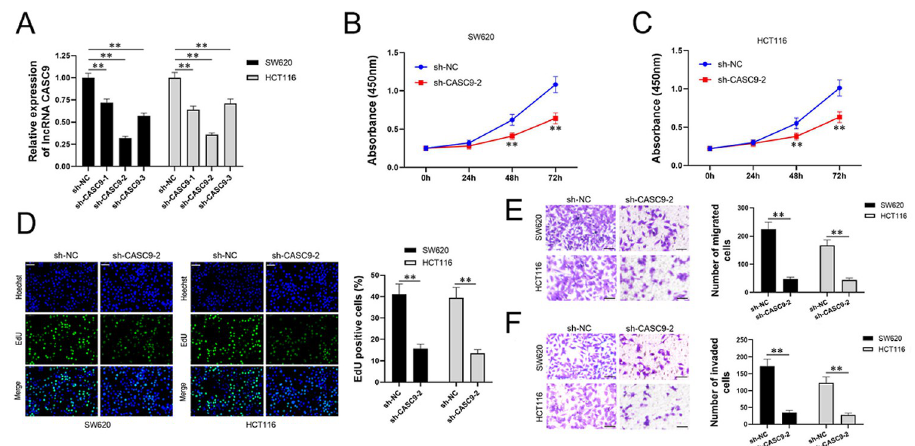
Fig 2. Downregulating lncRNA CASC9 inhibits proliferation and invasion of CRC cells. Relative expression of lncRNA CASC9 in SW620 and HCT116 cell lines of CRC were determined by qPCR, Black represents SW620 and grey represents HCT116 in histograms. (A)Subsets were defined as sh-NC, sh- CASC9 -1, sh- CASC9 -2, and sh- CASC9 -3. sh- CASC9 -2 downregulated the expression of lncRNA CASC9 most significantly. (B&C) Then, we respectively detected the proliferation of SW620 and HCT116 on sh-NC and sh- CASC9 -2 subsets at 0, 24, 48, and 72h via CCK8, the proliferation of both SW620 and HCT116 with sh- CASC9 -2 were significantly slower than the sh-NC subset, and the inhibitory effect was in a time-dependent manner. Blue represents the sh-NC subset, and red represents the sh- CASC9 -2 subset. (D) EdU assay indicated that knocking down lncRNA CASC9 significantly inhibited the proliferation of CRC. Histograms of Edu positive cells on sh-NC and sh- CASC9 -2 subsets are quantized results of left pictures. (E&F) Transwell was tested for invasion and migration of SW620 and HCT116 cell lines on sh-NC and sh- CASC9 -2 subsets. Sh- CASC9 -2 subsets showed significant inhibition of invasion and migration. The upper picture is about migration, and the below one is about invasion. The histograms are the quantitative analysis of the left pictures. Scale bar = 50 μ m. � P < 0.05 and �� P < 0.01.